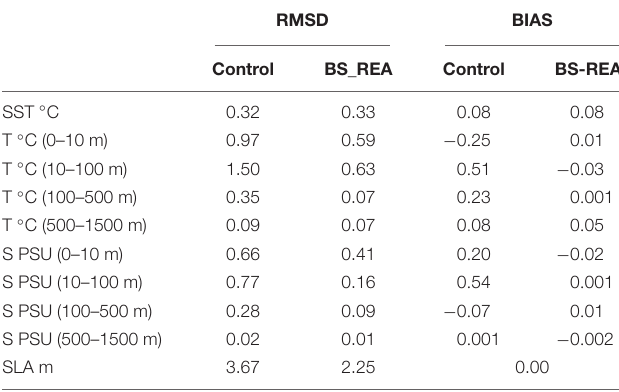
TABLE 2 | EAN estimations for BS-REA and the control experiment without data assimilation. RMSD BIAS Control BS_REA Control